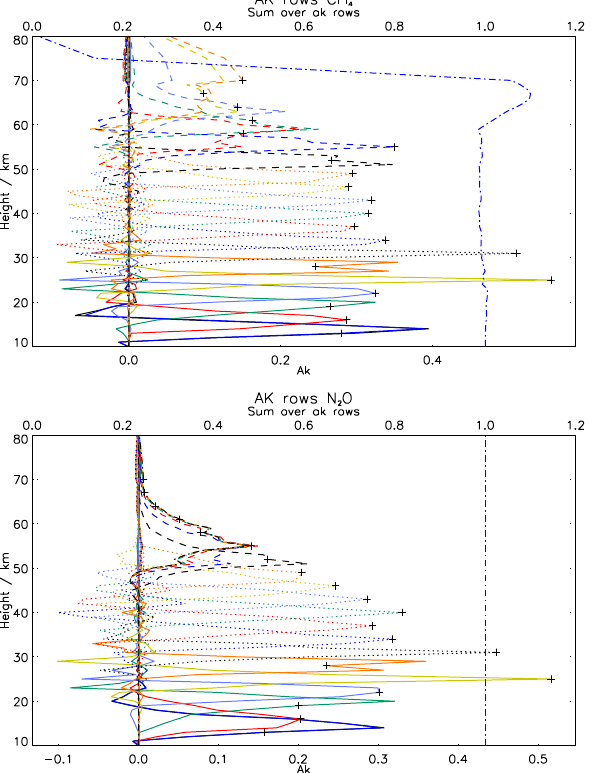
Figure 10. Selected rows of the averaging kernel matrix for the 1 measurement in orbit 43202 at 39.4 ◦ N, 78.9 ◦ E on 5 June 2010, 05:02:29UTC (derived from reduced-resolution spectra, version V5R_CH4_224). The black crosses highlight the diagonal terms of the averaging kernel matrix. The blue dashed-dotted line gives the integral value of the rows (upper axis). The upper panel shows re- sults for CH 4 and the lower panel shows results for N 2 O. 1 Figure 11. Estimated error contributions for the measurement in orbit 43202 at 39.4 ◦ N, 78.9 ◦ E on 5 June 2010, 05:02:29UTC (de- rived from reduced-resolution spectra, versions V5R_CH4_224 and V5R_N2O_224). Left panels: gas profiles, right panels: contribu- tions of different errors. All contributions are absolute values, ex- cept for the total relative error, which is given as a percentage (%; upper axis). The upper panels show results for CH 4 ; the lower pan- els show results for N 2